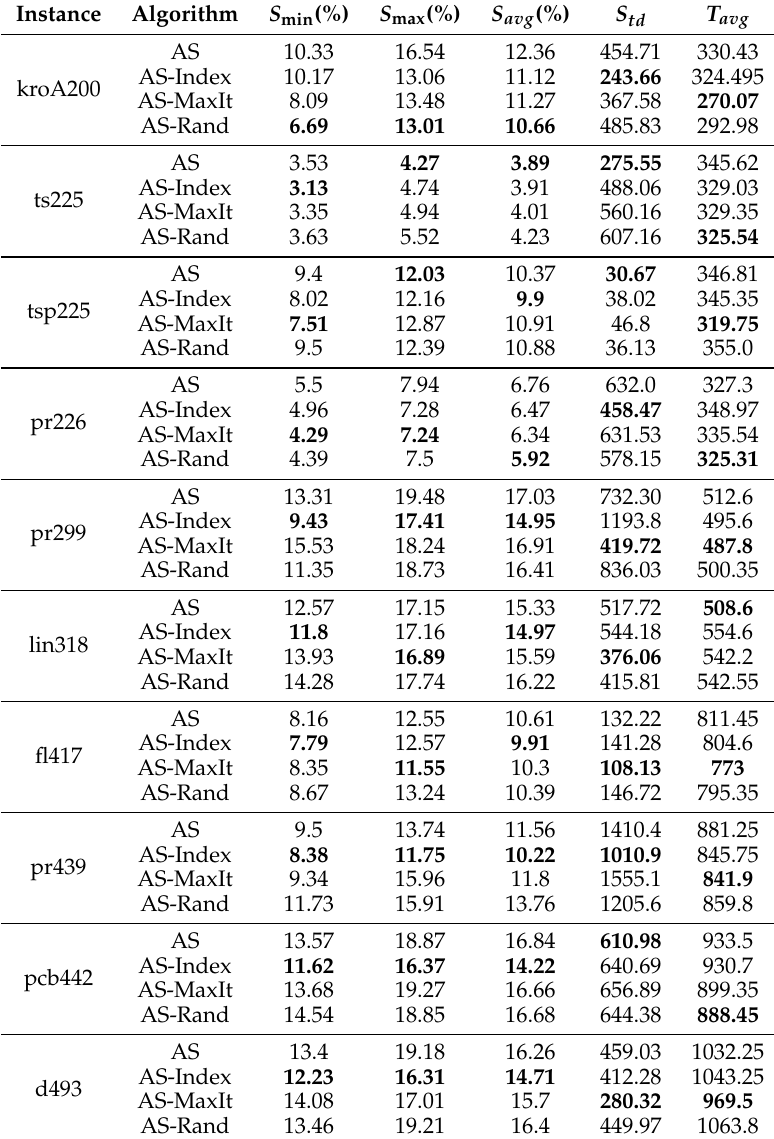
Figure 1. Evolutionary curves for different iteration periods based on kroA100. Table 2. Results comparison for medium-scale example